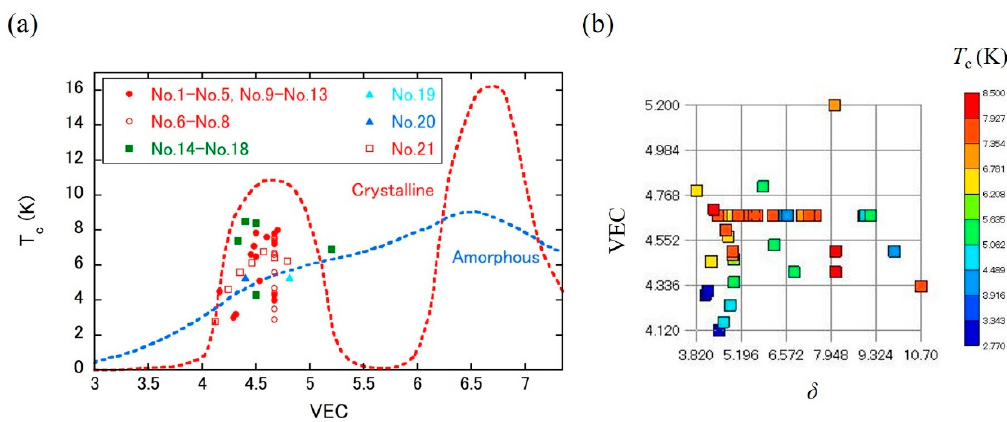
Figure 3. ( a ) VEC dependence of T c for bcc HEA superconductors. The same dependences are also shown for the crystalline 4 d metal solid solution and amorphous 4 d metal superconductors by the dotted lines. Data for the dotted lines are from [16]. ( b ) δ and VEC dependence of T c for bcc HEA superconductors.